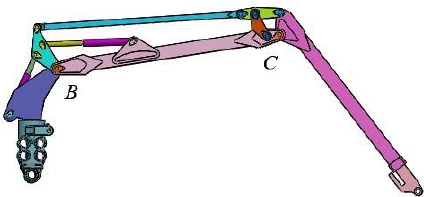
Figure 1. The boom model and structure diagram.